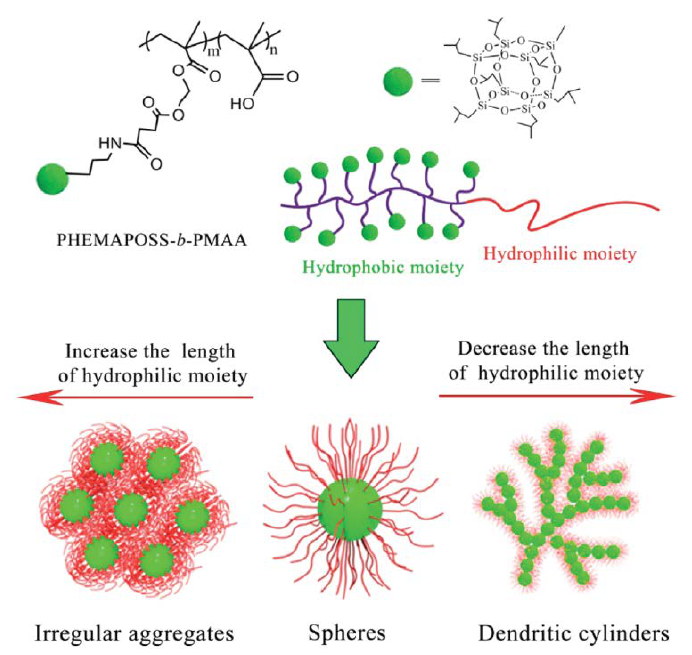
Figure 8. Self-assembly behaviors of PHEMAPOSS- b -PMAA in water with different lengths of hydrophilic PMAA moieties. Reprinted with permission from [35]. Copyright (2014) American Chemical Society.